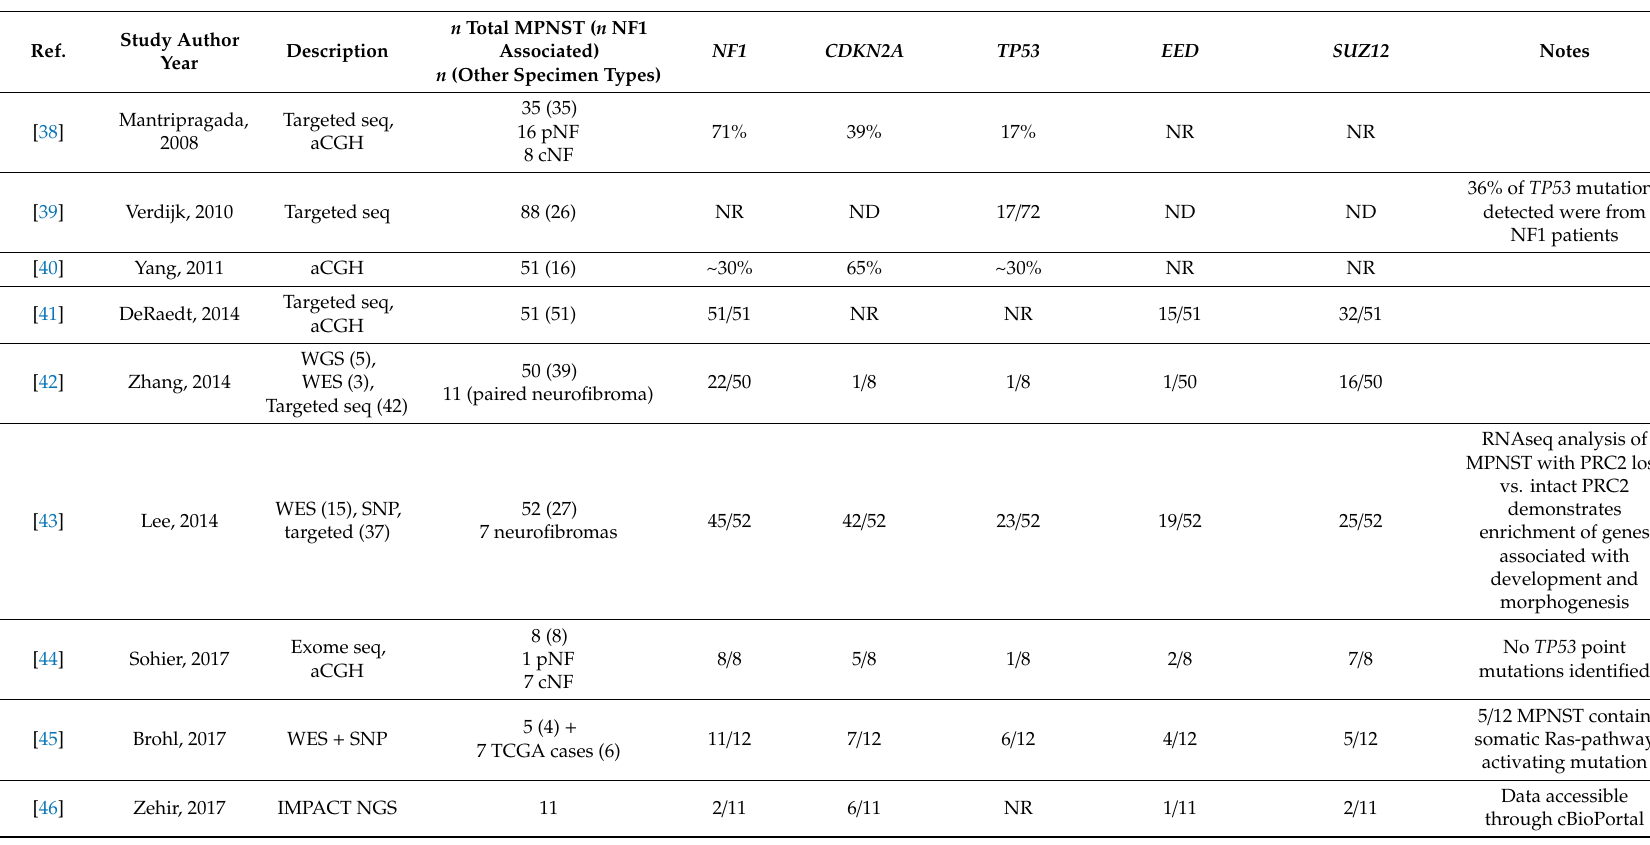
Table 1. Genomic sequencing studies for most common genetic alterations in human MPNST. All MPNST or neurofibromas in study reported under n . Reported sequencing results given as in reference (cases or percentages) for human MPNST specimens.